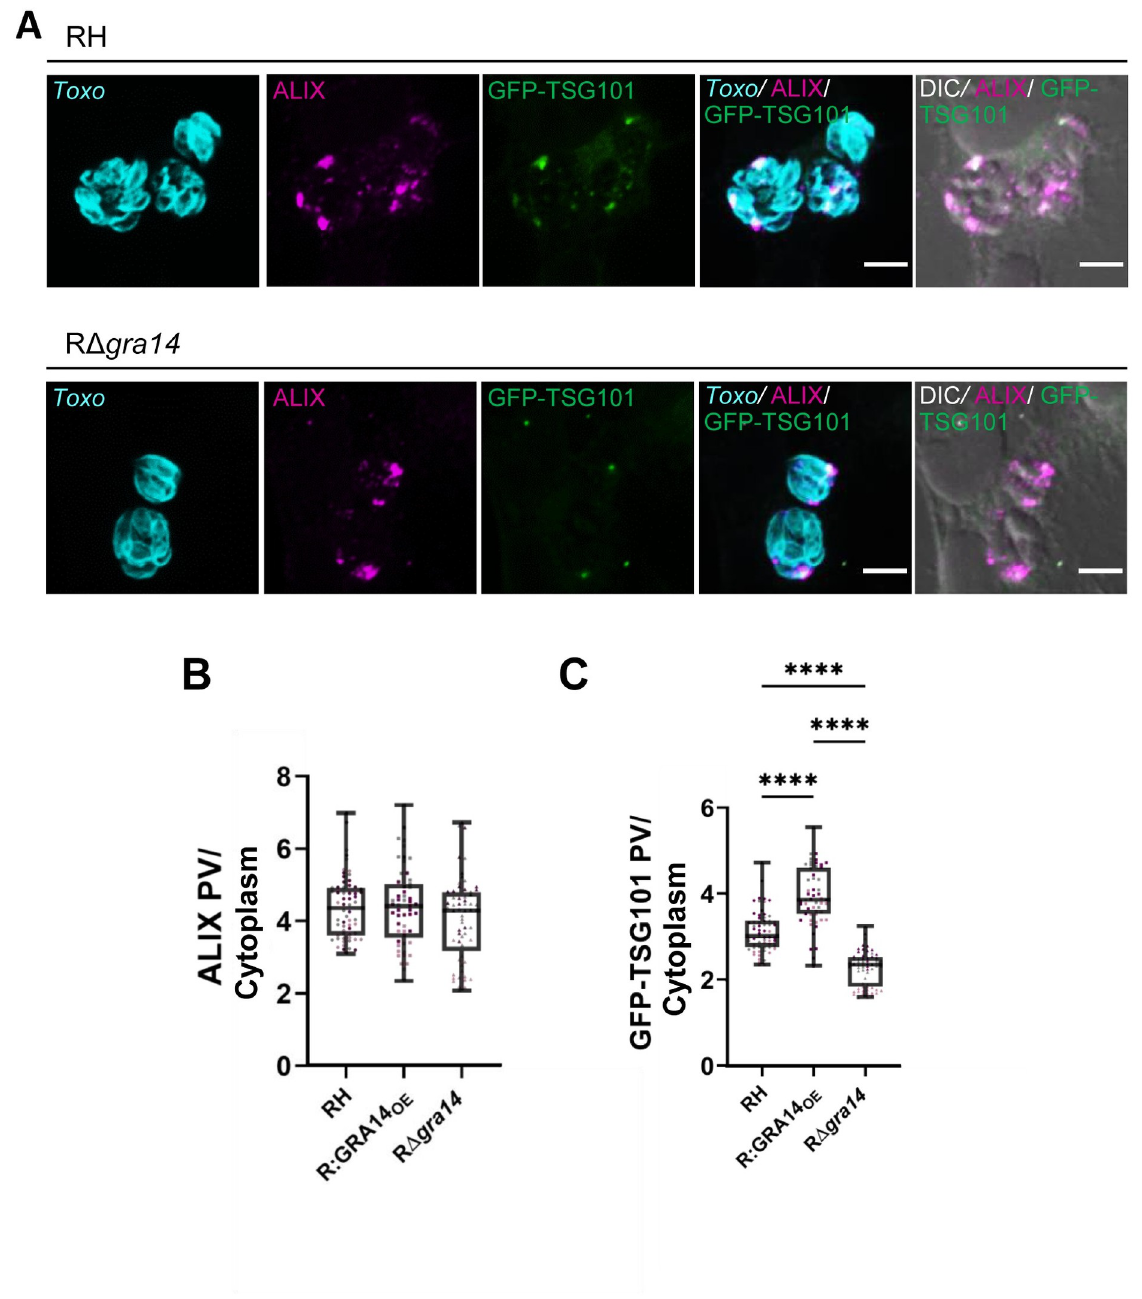
Fig 4. TgGRA14 influences recruitment of GFP-TSG101 to the PV but not association of ALIX with the PV. A. Representative images from three biological replicates comparing the recruitment of ALIX and GFP-TSG101 between WT and R Δ gra14 . Images were analyzed by confocal microscopy. Scale bar is 5 μ m. B. Quantification of ALIX recruitment to the PV between RH, R Δ gra14 , R:GRA14 OE . Data represent the mean ALIX intensity at the PV relative to the cytosol (PV/cytosol). Each point represents the well average. (~18 wells per biological replicates (n = 3)). C. Quantification of TSG101 recruitment to the PV between RH, R Δ gra14 , R:GRA14 OE parasites. Data represent the mean TSG101 intensity in the PV relative to the cytosol (PV/cytosol). Each point represents the well average. (~18 wells per biological replicates (n = 3)). Statistical analysis was done using Kruskal-Wallis test. Only statistical differences are shown. ���� p < 0.0001.